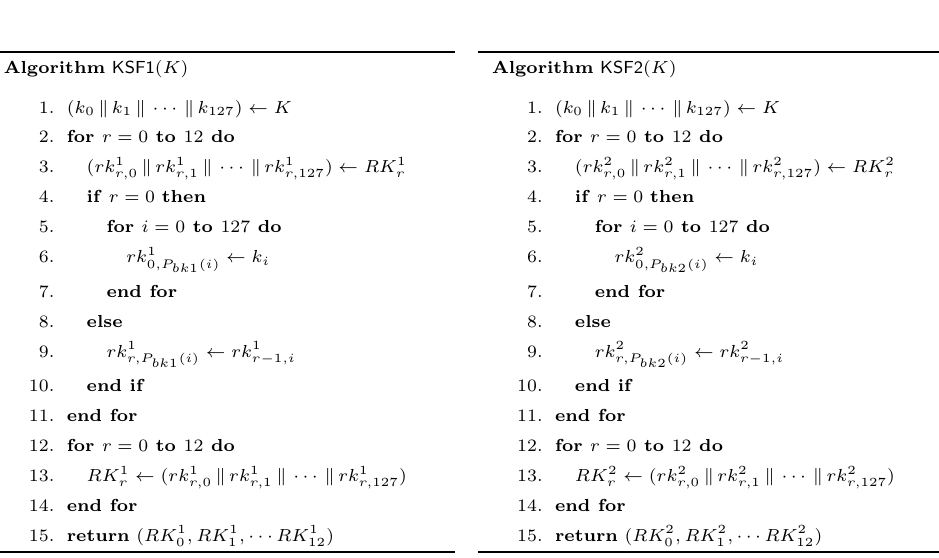
Figure 2: Algorithms of KSF1 and KSF2 .